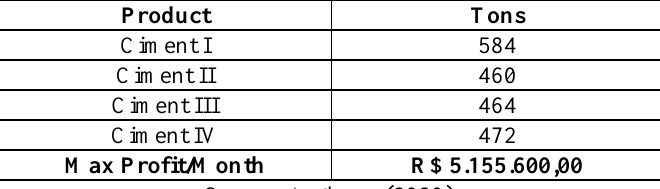
Table 2: Optimized production result.